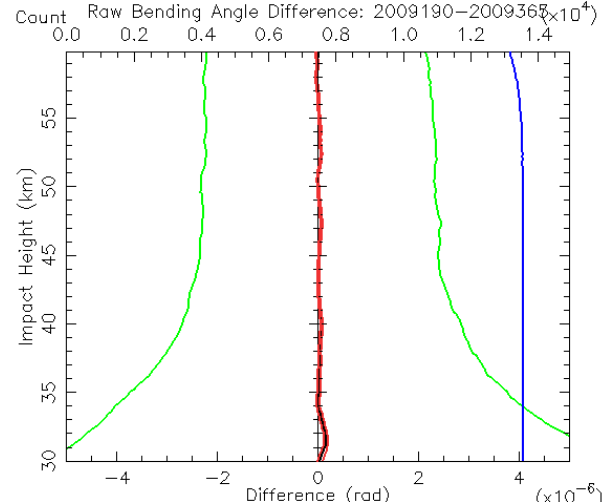
Fig. 19. This plot shows the mean (black), standard deviation (green), standard deviation of the mean (red), and number of sam- ples (blue) as a function of impact height for global differences be- tween FM3 and FM4 bending angles from 2006.200-365.